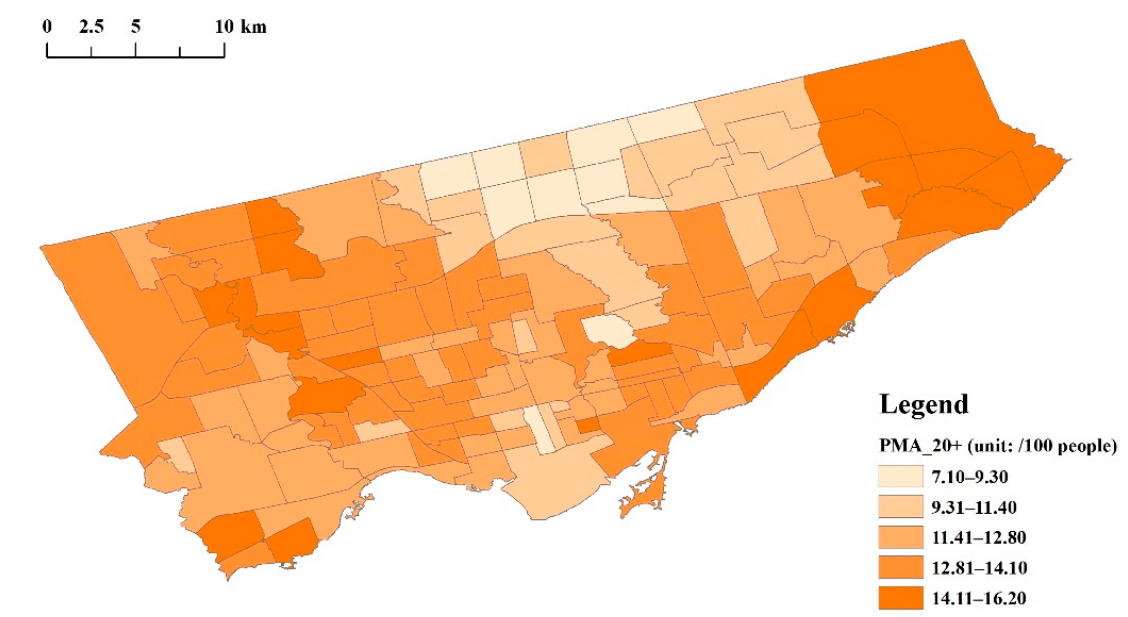
Figure A7. Distribution of the prevalence of female asthmatics aged 20 years and above (PFA_20+).